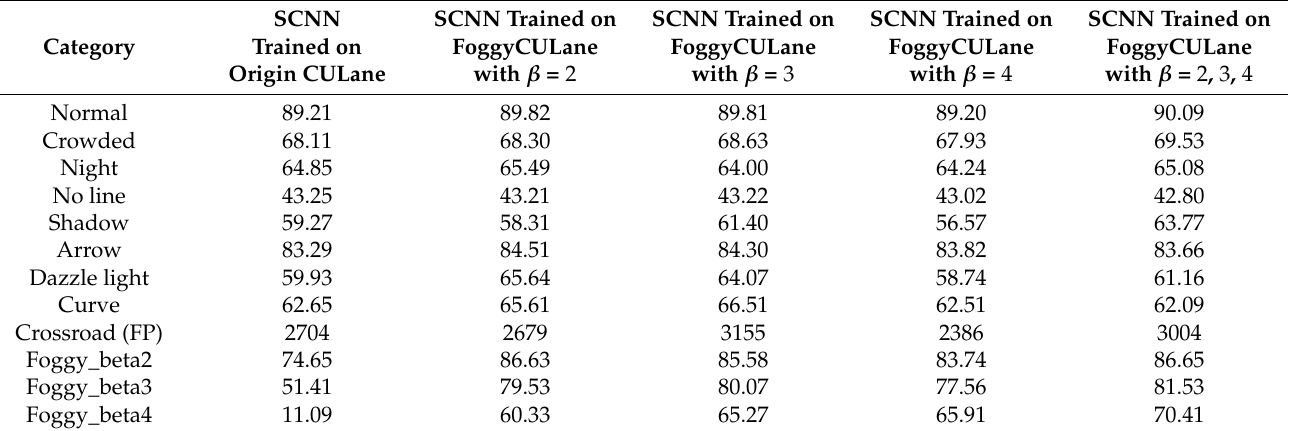
Table 3. Evaluation results (F1-measure) of SCNN tested in different scenes, with the model trained with different datasets.